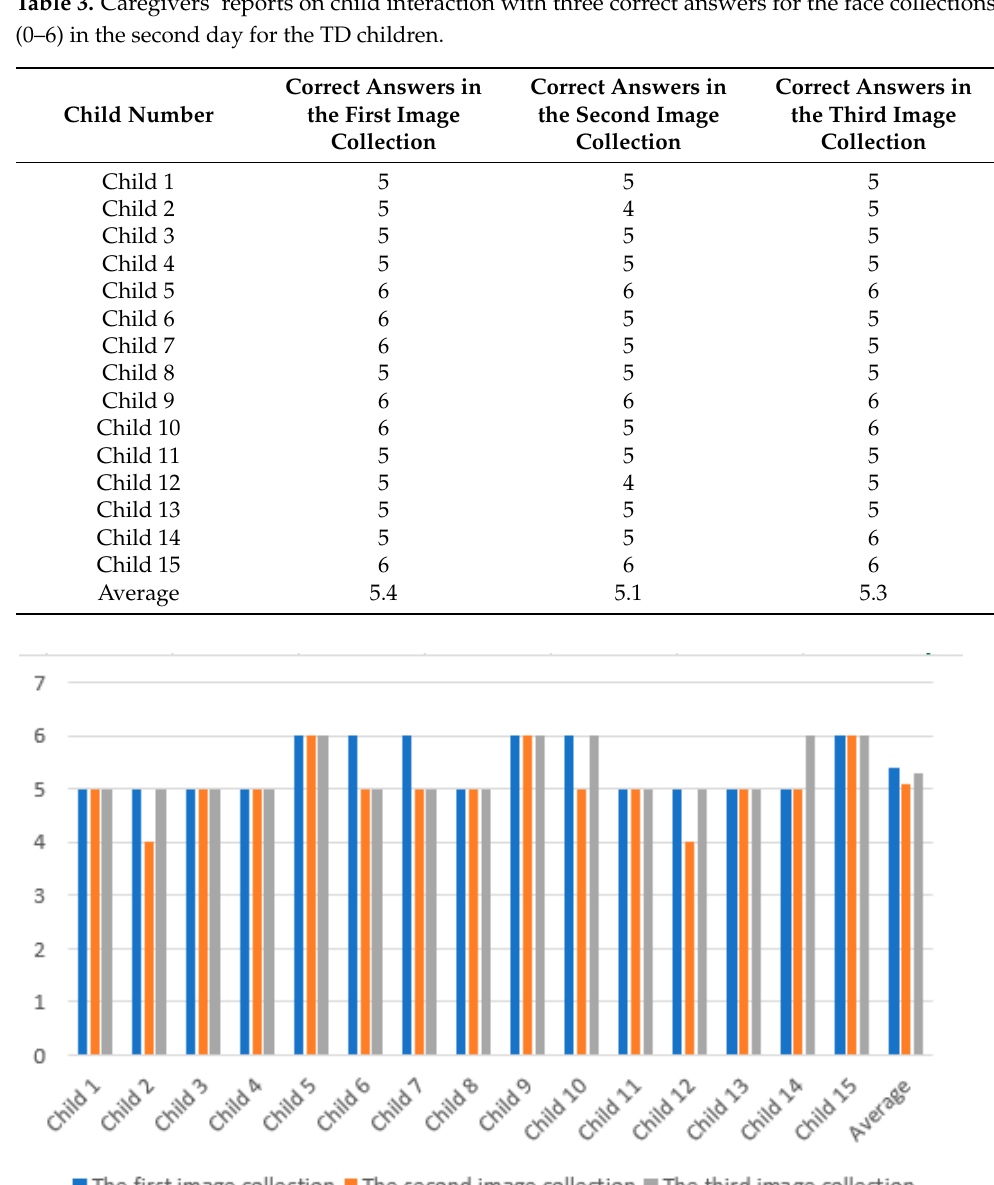
Figure 7. TD children’s interaction with the three face collections on the second day.